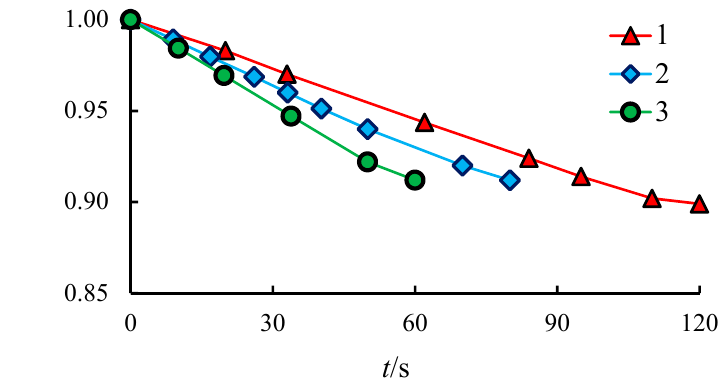
Figure 3. Change of powder mass over time ( m 0 —initial powder mass): 1 − U 0 = 0 mm/s; 2 − U 0 = 0.2 mm/s; and 3 − U 0 = 0.6 mm/s.